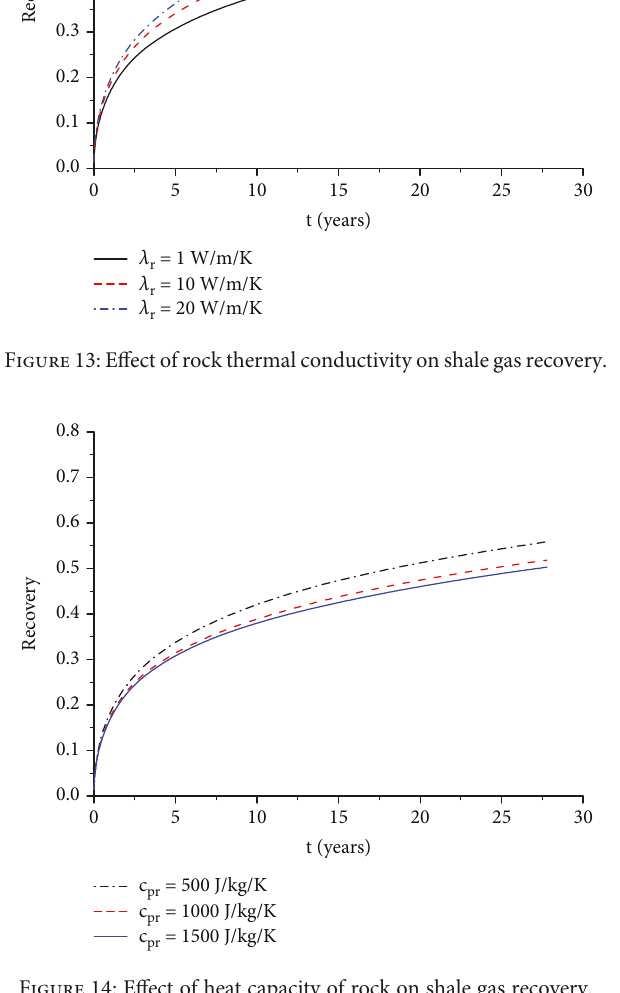
Figure 14: E ff ect of heat capacity of rock on shale gas